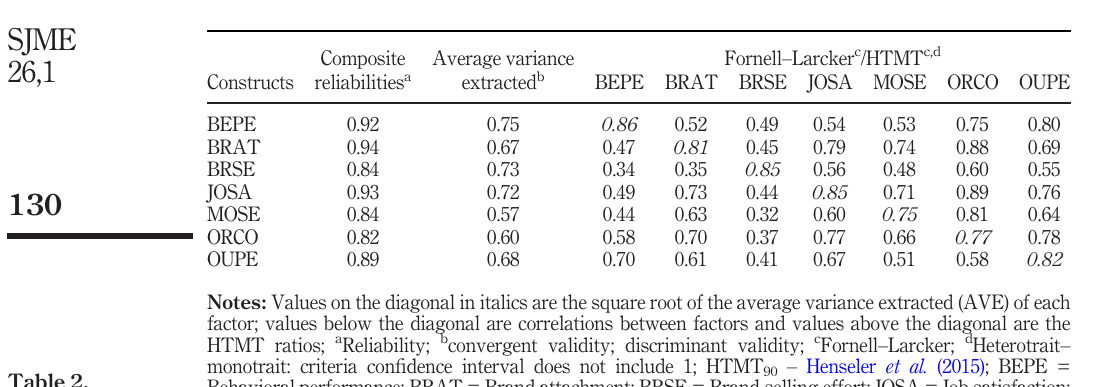
Table 2. Measurement